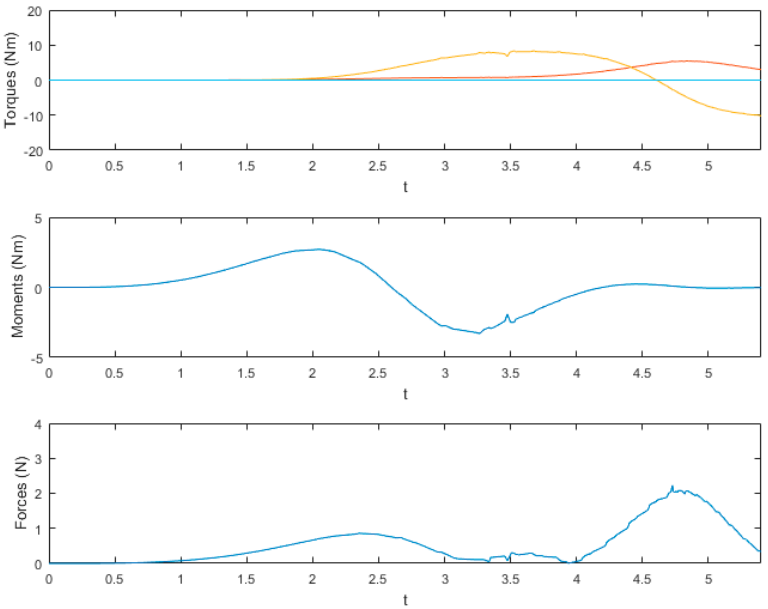
Figure 5. ( a ) Experiment 1: Joint torque and moment and force exerted on the base platform. ( b ) Experiment 2: Joint torque, moment, and force exerted on the base platform.